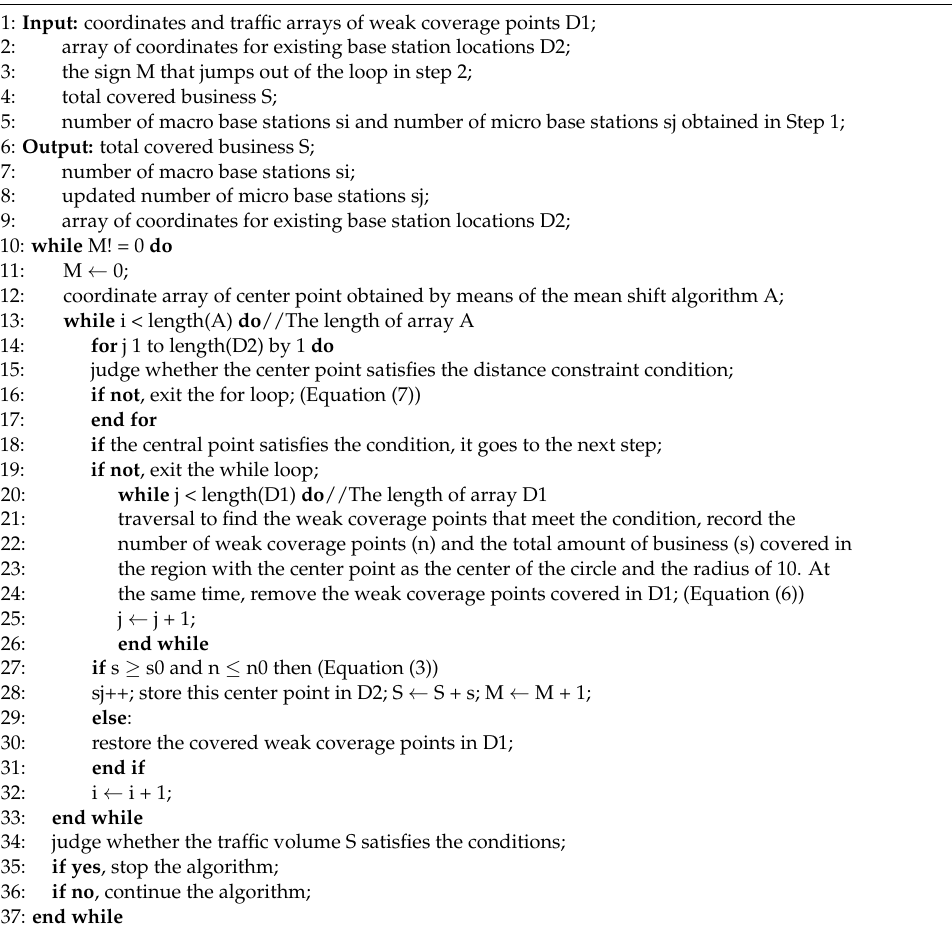
Algorithm 2: Algorithm based on mean shift clustering to determine the number of micro base